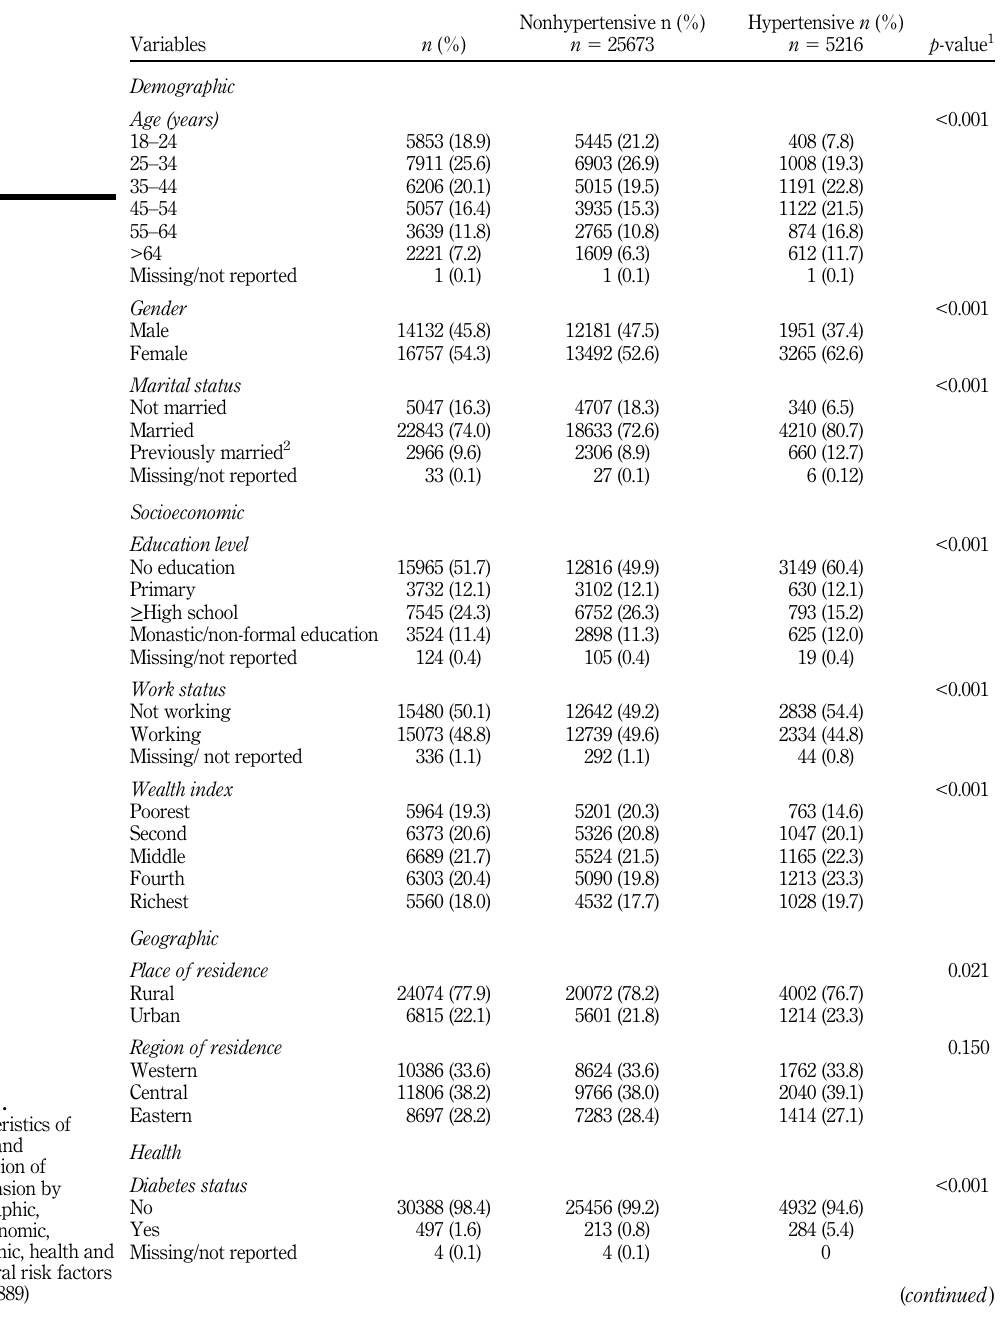
Table 1. Characteristics of sample and distribution of hypertension by demographic, socioeconomic, geographic, health and behavioral risk factors ( n 5